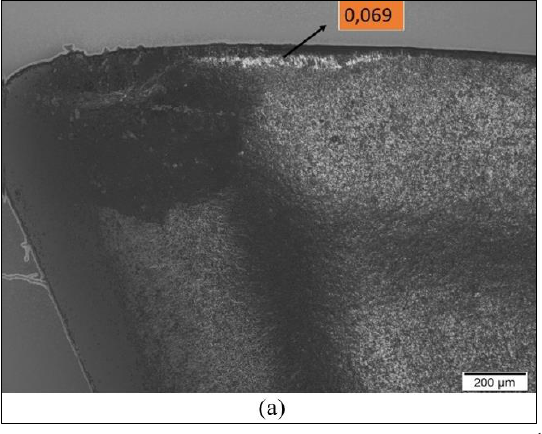
Figure 5a: Wear on the main flank with insert 0,8 mm: (a) Without sealant.